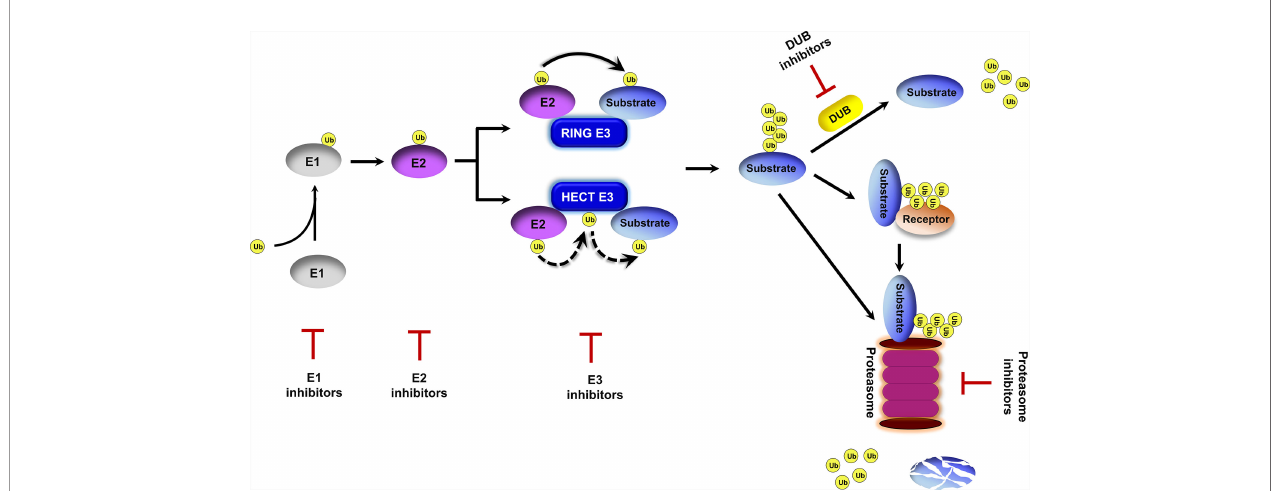
FIGURE 1 | Overview of the ubiquitin proteasome system. Ubiquitin is activated by an E1 enzyme and transferred to an E2 enzyme. The activated ubiquitin is then transferred from the E2 to the substrate in a repeated process mediated by an E3 ubiquitin ligase to form a polyubiquitin chain on the protein substrate. This ubiquitination process can be reversed by deubiquitinating enzymes (DUBs). Polyubiquitinated substrates are either delivered to the proteasome by ubiquitin receptors or directly recognized by the proteasome for cleavage into small peptides and the release of ubiquitin molecules. Inhibitors targeting E1s, E2s, E3s, DUBs and the proteasome have been proposed.